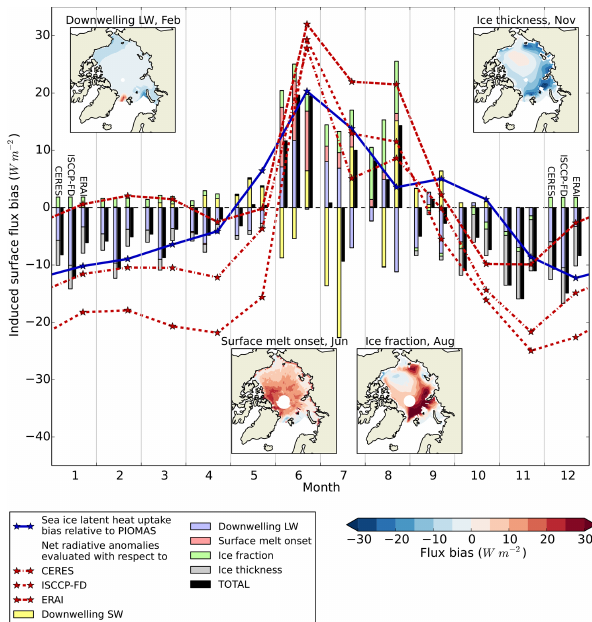
Figure 7. Surface flux bias induced by model biases in ice fraction, melt onset occurrence, ice thickness, downwelling SW and down- welling LW respectively for the Arctic Ocean region in HadGEM2- ES, 1980–1999. Total ISF bias is indicated by black bars. For each month, induced surface flux biases are estimated using in turn CERES, ISCCP-FD and ERAI as radiation reference datasets, from left to right. Sea ice latent heat flux uptake bias relative to PIOMAS is indicated in black. Net radiative flux biases relative to CERES, ISCCP-FD and ERAI are indicated in brown. Spatial patterns of induced surface flux bias for four processes in key months, with CERES as reference dataset, are displayed beneath and above (© Crown copyright 2019. Distributed under the Creative Commons Attribution 4.0